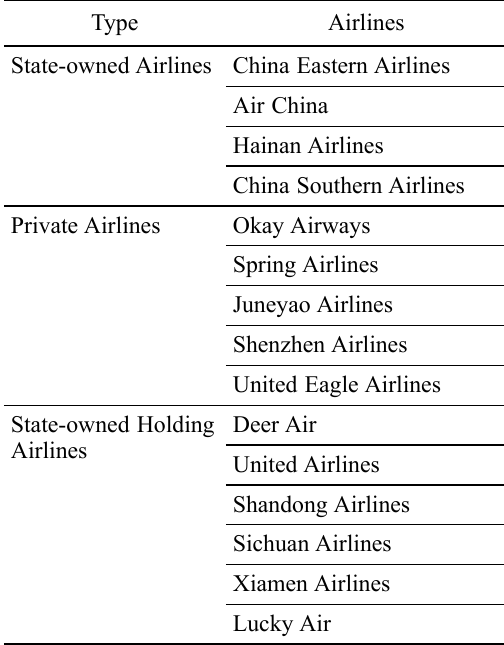
Table 2. Categories of the selected Chinese